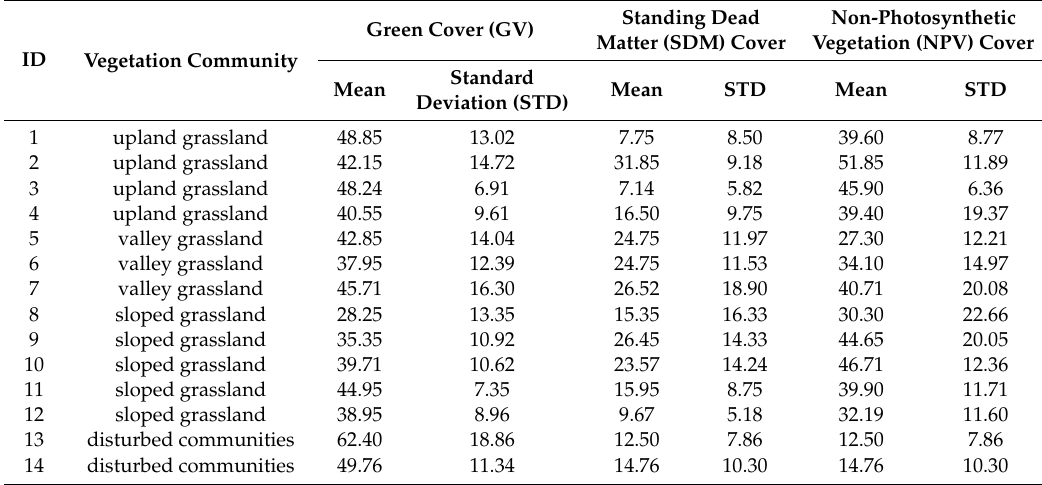
Table 2. Descriptive statistics for the coverage data based on visual